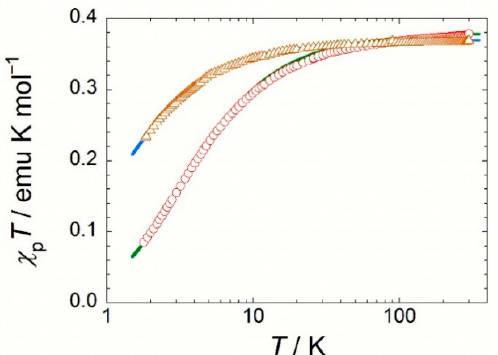
Figure 4. Temperature dependences of χ p T of 2-BiTHNN (open circles) and 2-THPNN (open tri- angles). Solid lines represent theoretical fitting on the basis of the 1D alternating AFM Heisenberg model (see the text).